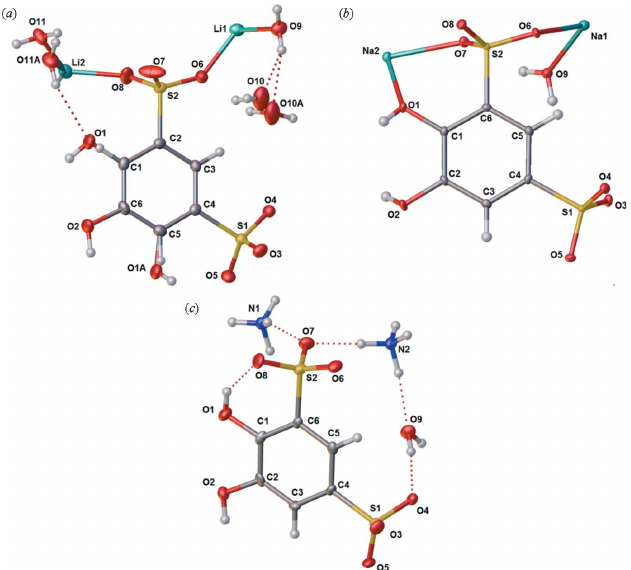
Figure 2 Displacement ellipsoid plots of the asymmetric unit contents for the crystal structures of tiron salts characterized in this study: ( a ) Li 2 (tiron) (cid:2) 2.5H 2 O, ( b ) Na 2 (tiron) (cid:2) H 2 O and ( c ) (NH 4 ) 2 (tiron) (cid:2) H 2 O. Ellipsoids are shown at the 50% probability. Hydrogen atoms shown as